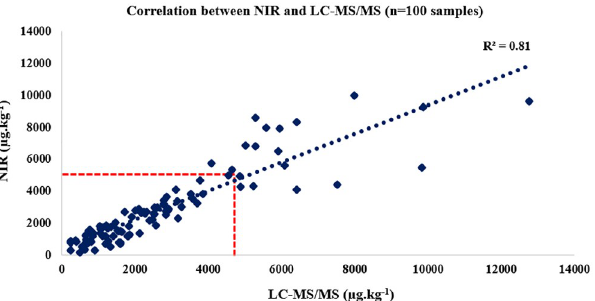
Fig 4. External validation of fumonisins: Correlation between Near Infrared Spectroscopy (NIR) and Liquid Chromatography Coupled to Tandem Mass Spectrometry (LC-MS/MS) in ground maize.